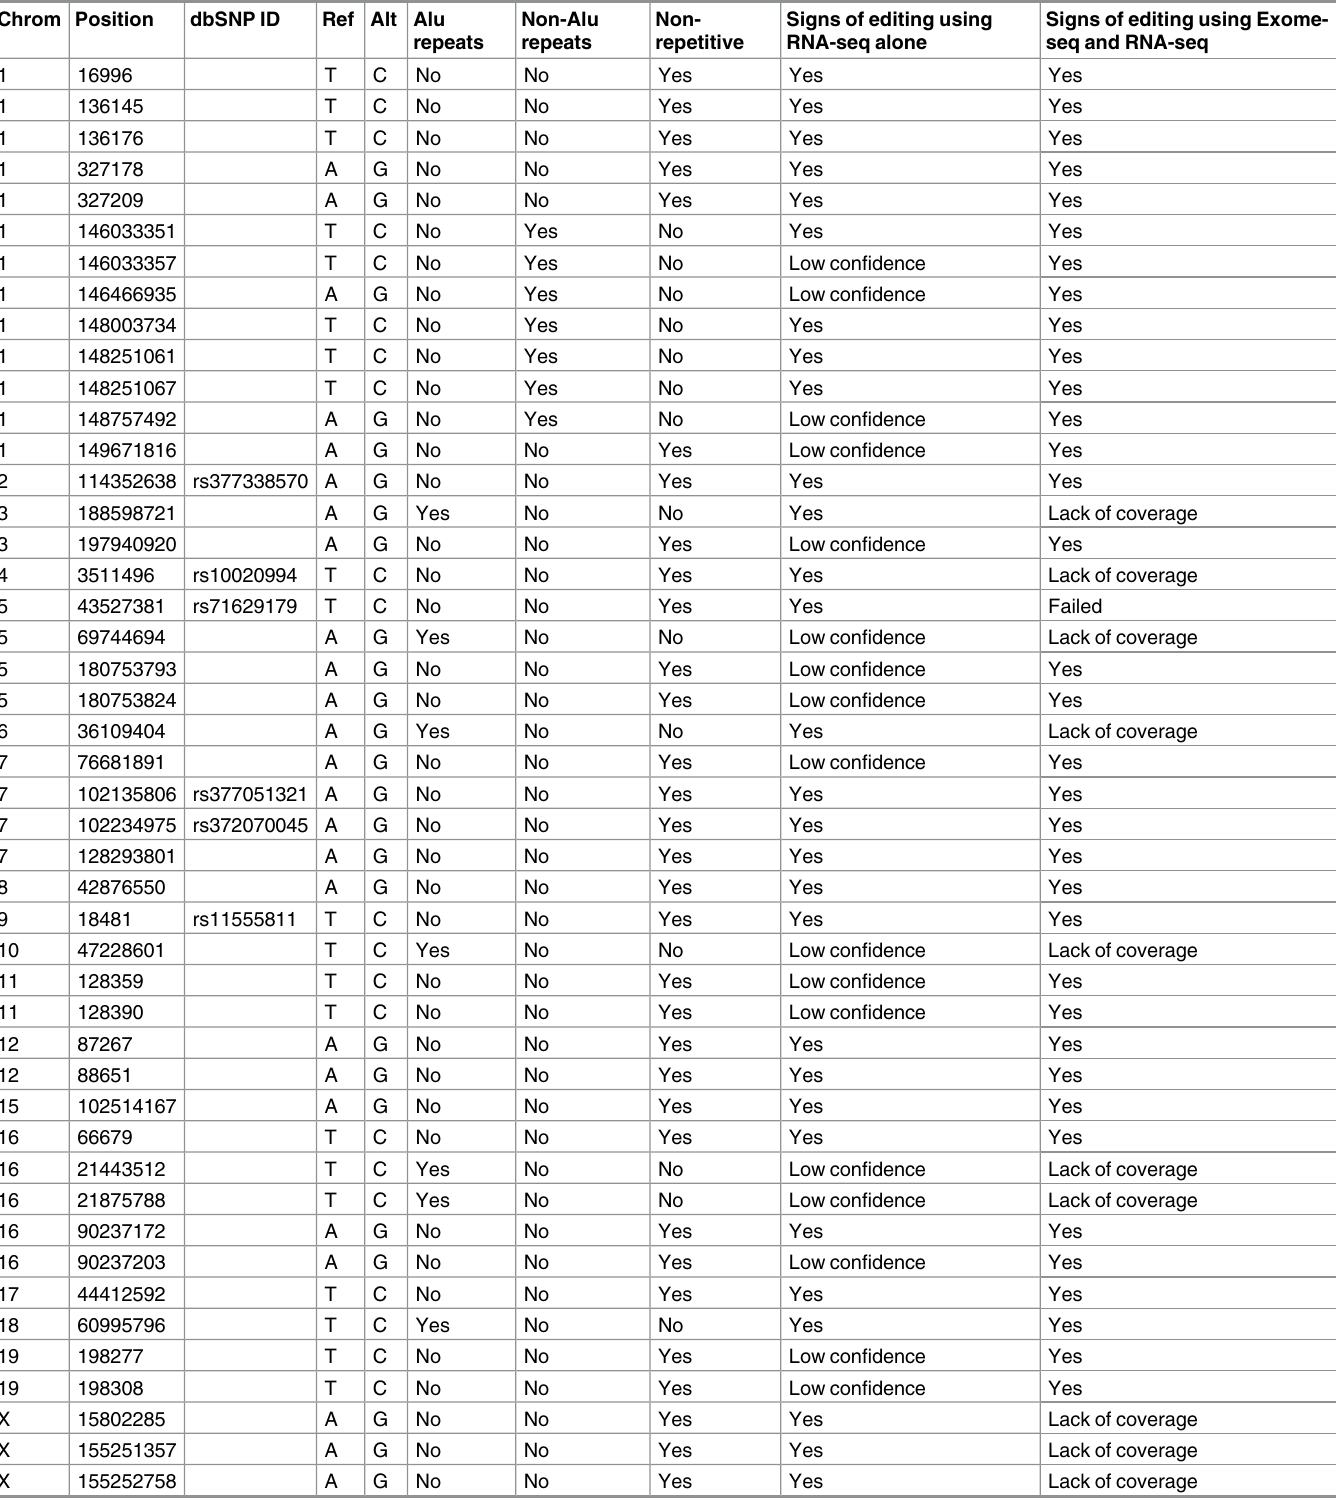
Table 5. Validation of putative A-to-I RNA editing events in 12 human islets using RNA-seq and Exome-seq. Chrom Position Non-Alu